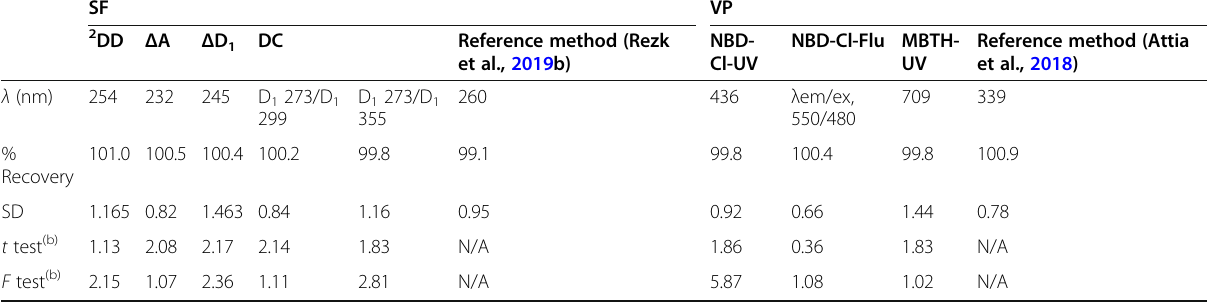
Table 4 Assay results for the determination of SF and VP in pharmaceutical dosage form a using all the proposed methods ( n = 5) SF VP